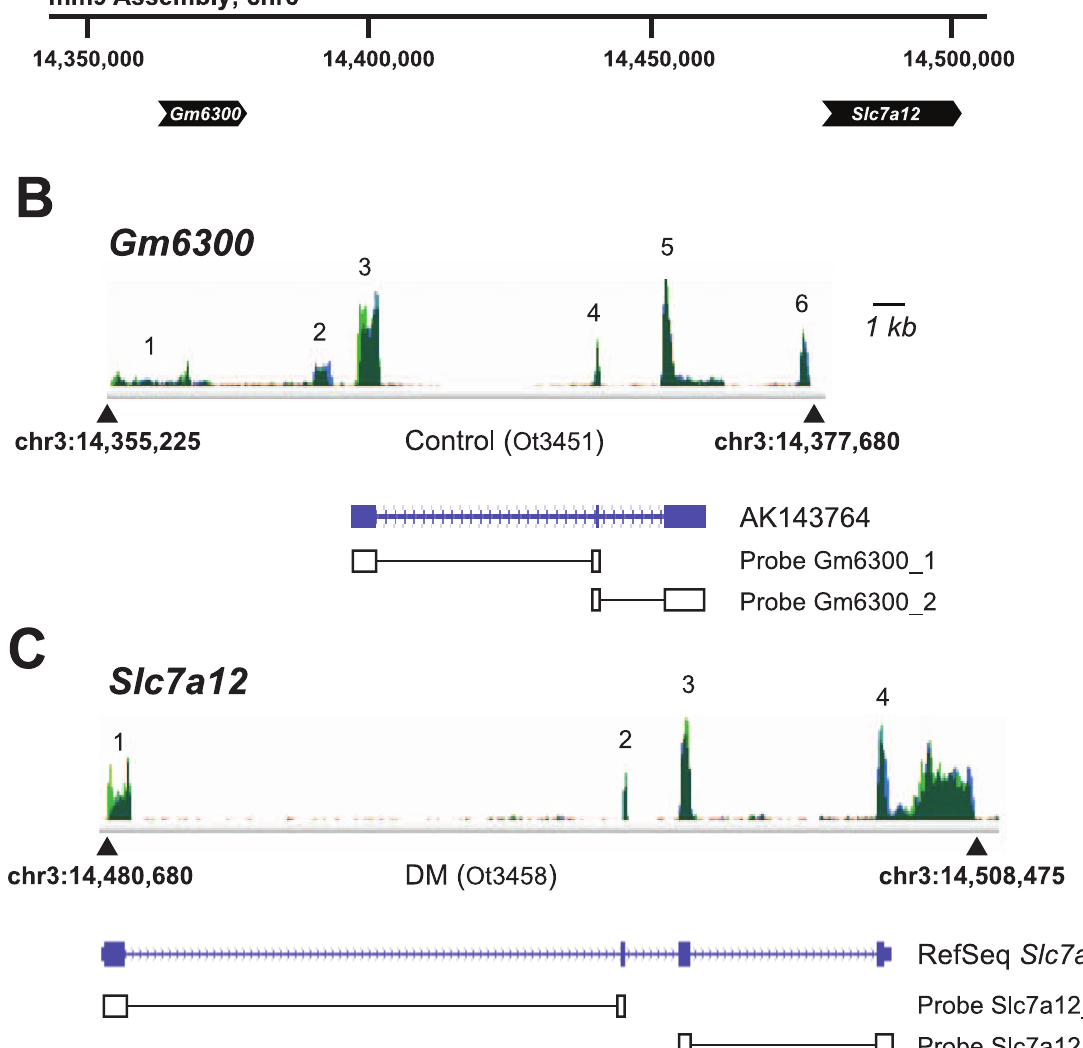
Figure 5. ‘‘Switching’’ expression from Gm6300 to Slc7a12 with induction of diabetes. RNA-Seq expression data for Slc7a12 and for the ‘‘pseudogene’’ Gm6300 , mapped on the mm9 murine genome assembly. The Gm6300 pseudogene shares homology with Slc7a12 and is , 125 kb upstream of Slc7a12 on chr3 ( A ); they appear to be paralogs. B . RNA-Seq expression data (green) for Gm6300 are shown for Control condition (representative sample Ot3451). Also shown are mm9 (chromosome 3) genomic coordinates, and clone AK143764 (the only known cDNA or EST matching the RefSeq Gm6300 gene; see Results). C . Depicted are the expressed regions of Slc7a12 (in green; between chr3:14,480,680–14,508,475) from a representative tracing of RNA-Seq transcripts from diabetic mouse kidney (sample Ot3458). Also shown is the exonic structure of the canonical Slc7a12 reference sequence (RefSeq). For B and C , note the alignment of expressed transcripts with the predicted exons. Not shown, there was essentially no Slc7a12 expression under Control conditions, and no Gm6300 expression under diabetic conditions (see text and Figure 6). For the canonical gene sequences AK143764 and Slc7a12 , exons are indicated by blue boxes, introns by an intervening blue line; CDS (in contrast to UTR) is designated by the taller blue boxes. Intron-spanning real-time PCR primer pairs (two primer/probe sets per gene, designated ‘‘_1’’ and ‘‘_2’’) are diagrammed and are used for generating data in Figure 6. The scale bar denotes 1 kb for B and C . Exons are labeled 1 through 6 ( B ) and 1 through 4 ( C ), based upon mapped RNA-Seq